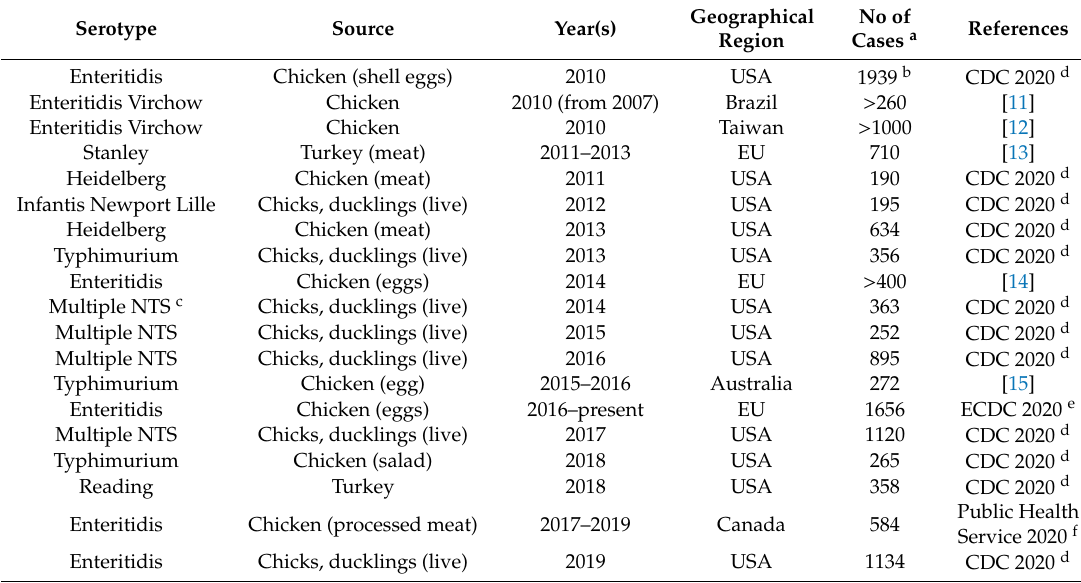
Table 1. Some of the global incidences of human salmonellosis linked to